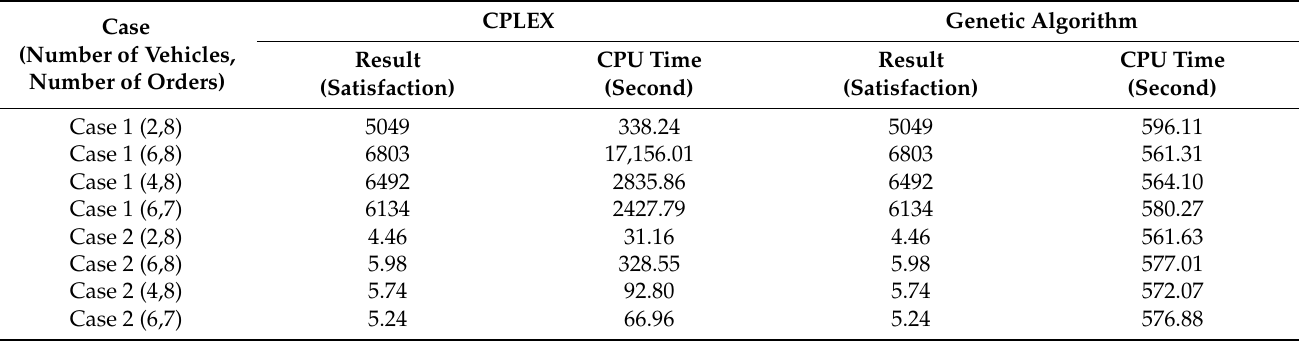
Table 5. The results of CPLEX and the genetic